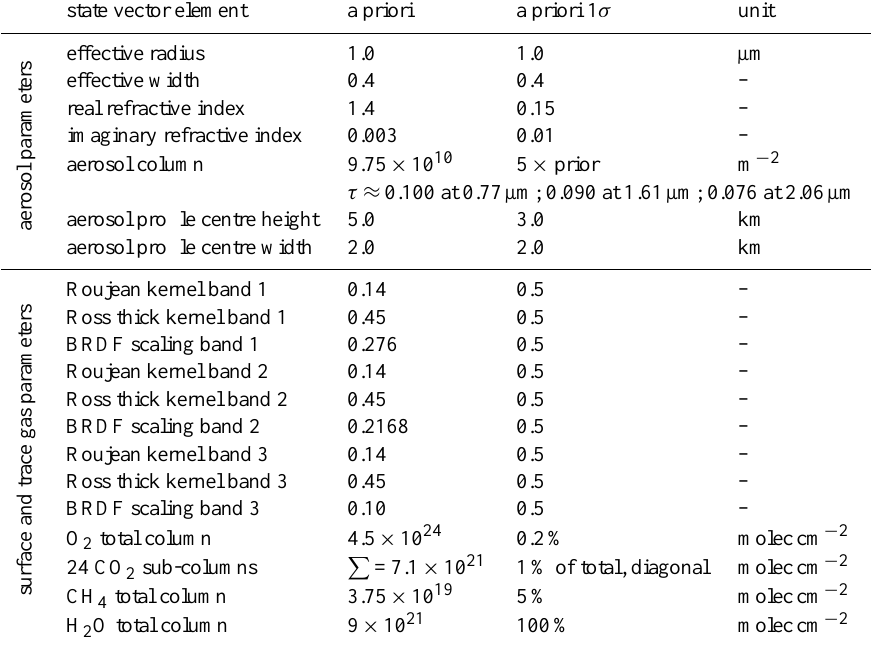
Table 1. State vector elements used in the simulations separated for aerosol parameters for a mono-modal size distribution (spherical) as well as surface and trace gas parameters. Aerosol size distribution is defined as 2-parameter gamma distribution according to Hansen and Travis (1974). BRDF scaling factors per band are roughly equivalent to the Lambertian albedos observed over Lamont. τ denotes aerosol optical density